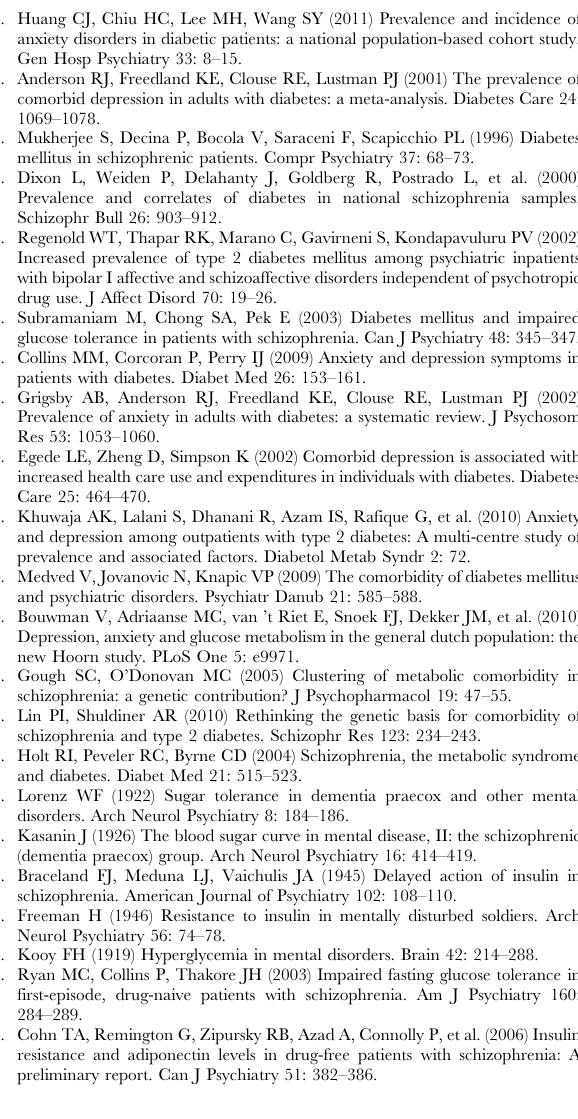
Figure 2. Behavioral analyses from Tcf7l2 overexpression. (A)–(C) Open field testing. (A) Center time shown as a percent of total time (%) in wild-type (WT, n=9) and BAC transgenic (BAC, n=9) mice. (B) Total distance shown in meters (m) in wild-type (WT, n=9) and BAC transgenic (BAC, n=9) mice. (C) Latency to periphery shown in seconds (s) in wild-type (WT, n=9) and BAC transgenic (BAC, n=9) mice. (D)–(F) Light dark box testing. (D) Time in light shown as a percent of total time (%) in wild-type (WT, n=9) and BAC transgenic (BAC, n=9) mice. (E) Number of transitions between the light and dark compartments in wild-type (WT, n=9) and BAC transgenic (BAC, n=9) mice. (F) Latency to the dark compartment shown in seconds (s) in wild-type (WT, n=9) and BAC transgenic (BAC, n=9) mice. (G) – (I) Fear conditioning. (G) Contextual fear shown as a percent time spent freezing (%) in wild-type (WT, n=9) and BAC transgenic (BAC, n=9) mice. (H) Cue-based fear shown as a percent time spent freezing (%) in wild-type (WT, n=9) and BAC transgenic (BAC, n=9) mice. (I) Pre-training freezing shown as a percent time spent freezing (%) in wild-type (WT, n=9) and BAC transgenic (BAC, n=9) mice. (J) Prepulse inhibition in wild-type (WT, n=9) and BAC transgenic (BAC, n=9) mice. Prepulse inhibition (%) using prepulses of 3, 6 and 12 decibels (dB) are shown. (K) Startle response in wild-type (WT, n=9) and BAC transgenic (BAC, n=9) mice. Wild-type data are shown in gray while BAC transgenic data are shown in orange.